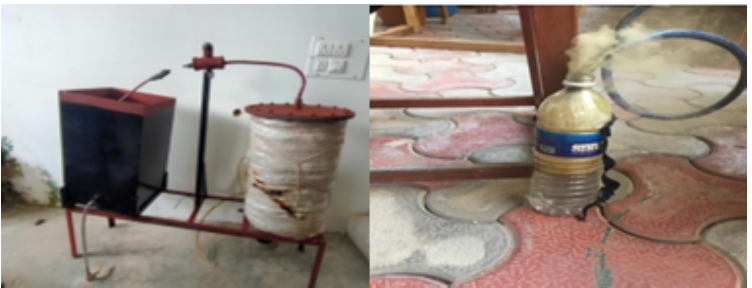
Figure 2. Setup for pyrolysis process of waste plastic into plastic oil